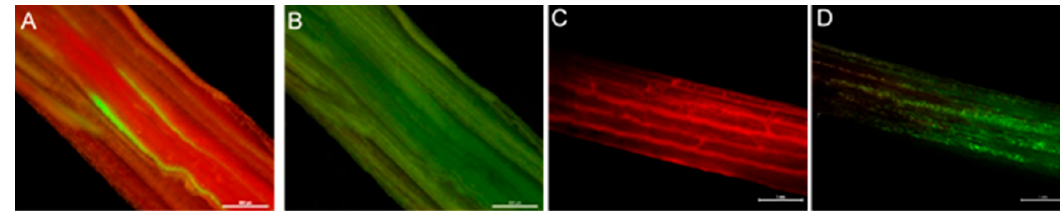
Figure 2. Fluorescence images of plant tissues inoculated with endophyte strain E1. ( A ) Expression of GFP at the base of a tiller. ( C ) Expression of DsRed in intercellular spaces of leaf sheath. ( B , D ) Corresponding bright-field images. Scale bar = 500 µM.